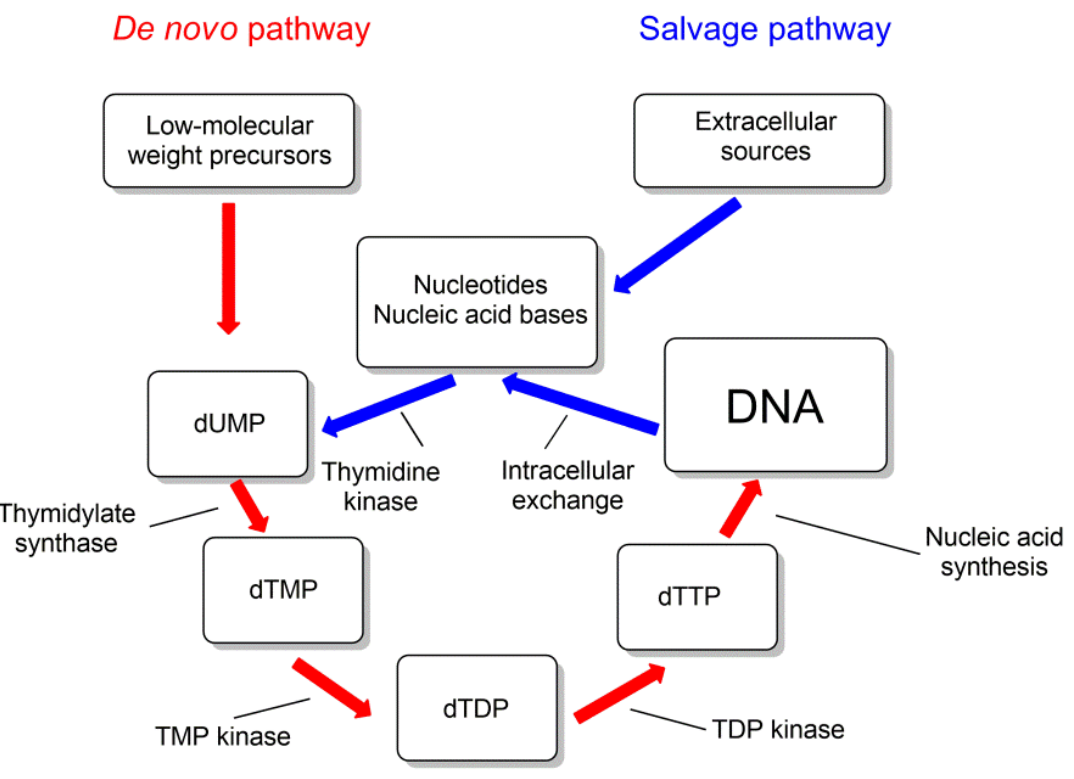
Figure 12. Metabolism of thymidine nucleotides.